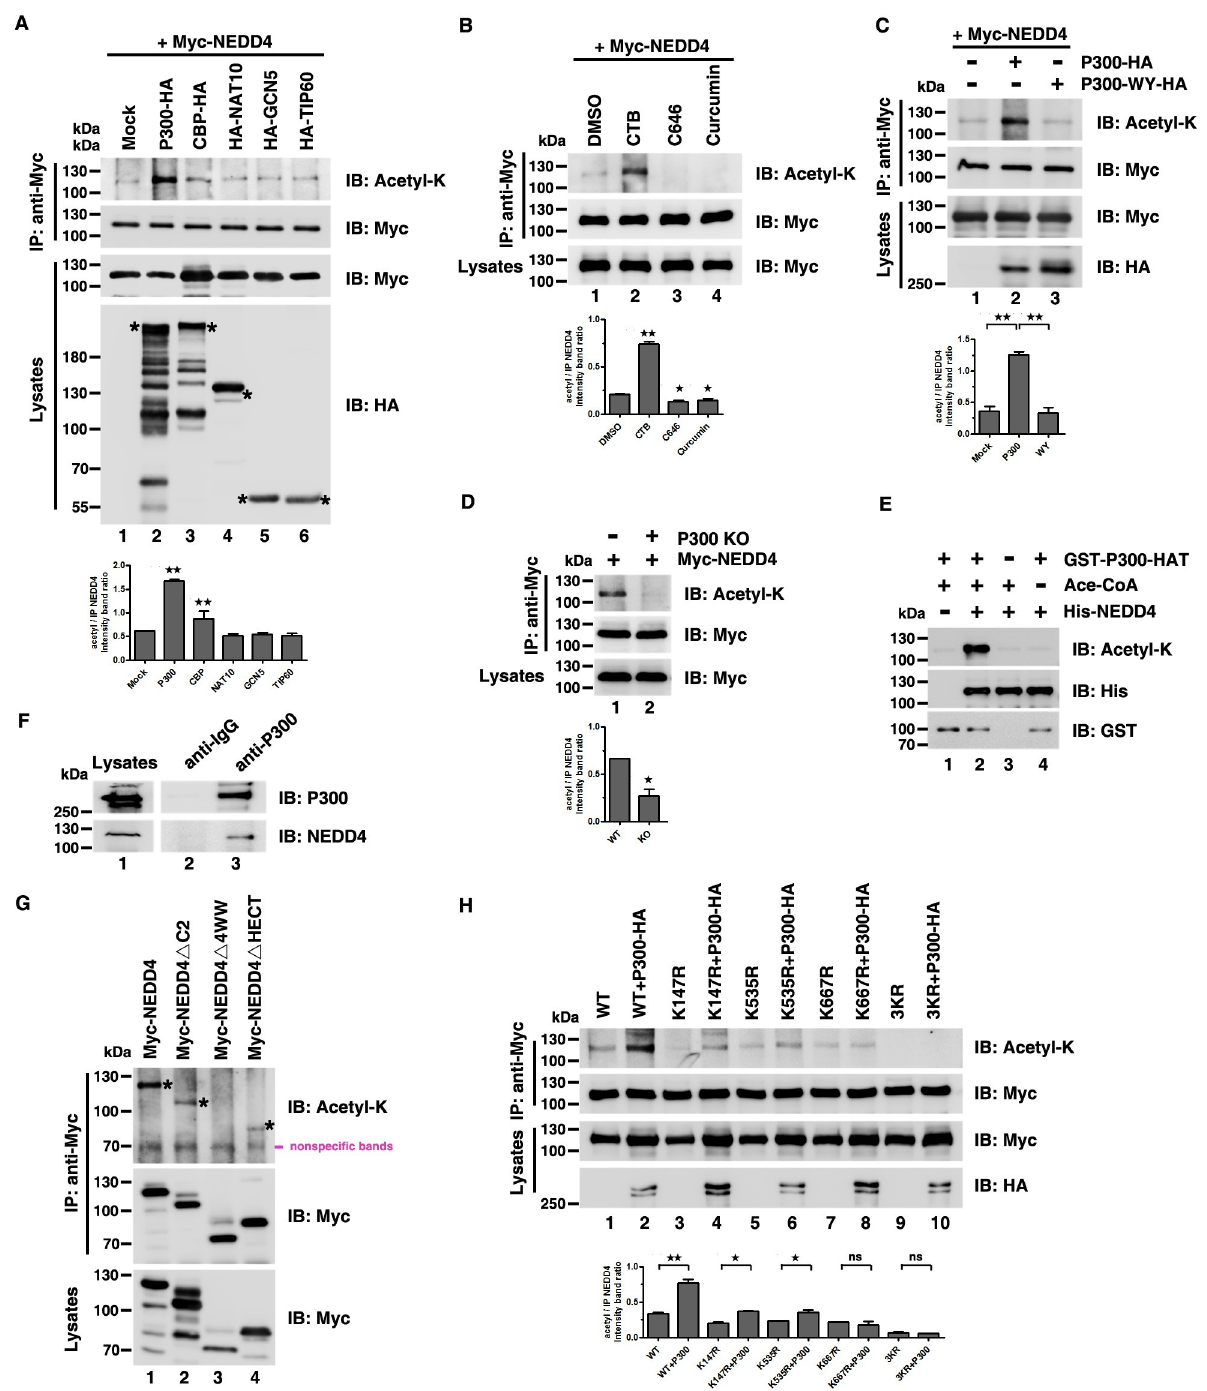
Fig 2. NEDD4 can be acetylated by P300. (A)-(C) NEDD4 acetylation in HEK293T cells was measured following overexpression of the indicated acetyltransferases targeted by “ � ” (A), treatment with the P300 activator CTB and inhibitors C646 and Curcumin (B), or overexpressing P300-HA and the acetyltransferase-inactive P300-WY-HA in P300 knockout (KO) cells (C). Cell lysates were immunoprecipitated with an anti-Myc antibody and analyzed via immunoblotting with an anti-Acetyl-K antibody to detect the acetylation of NEDD4. (D) NEDD4 acetylation was measured in HEK293T WT and P300 KO cells. (E) In vitro acetylation assays were measured by incubating purified His-NEDD4 with purified GST-P300-HAT followed by immunoblotting with an anti-Acetyl-K antibody to detect the acetylation of NEDD4. (F) Interaction between endogenous P300 and NEDD4. (G) Acetylation of Myc-NEDD4 and mutants was measured in HEK293T cells. (H) HEK293T cells were transfected with the indicated plasmid